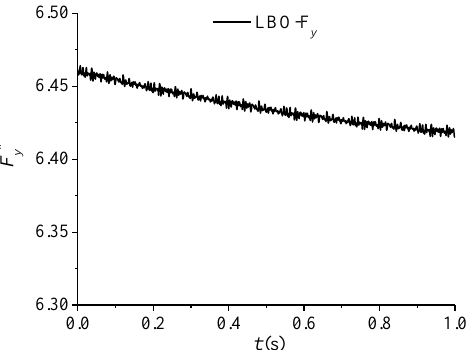
Figure 15. The axial water thrust of the runner lower band inner surface. ( a ) Time domain diagram of LBI-F y . ( b ) Frequency domain diagram of LBI-F y .